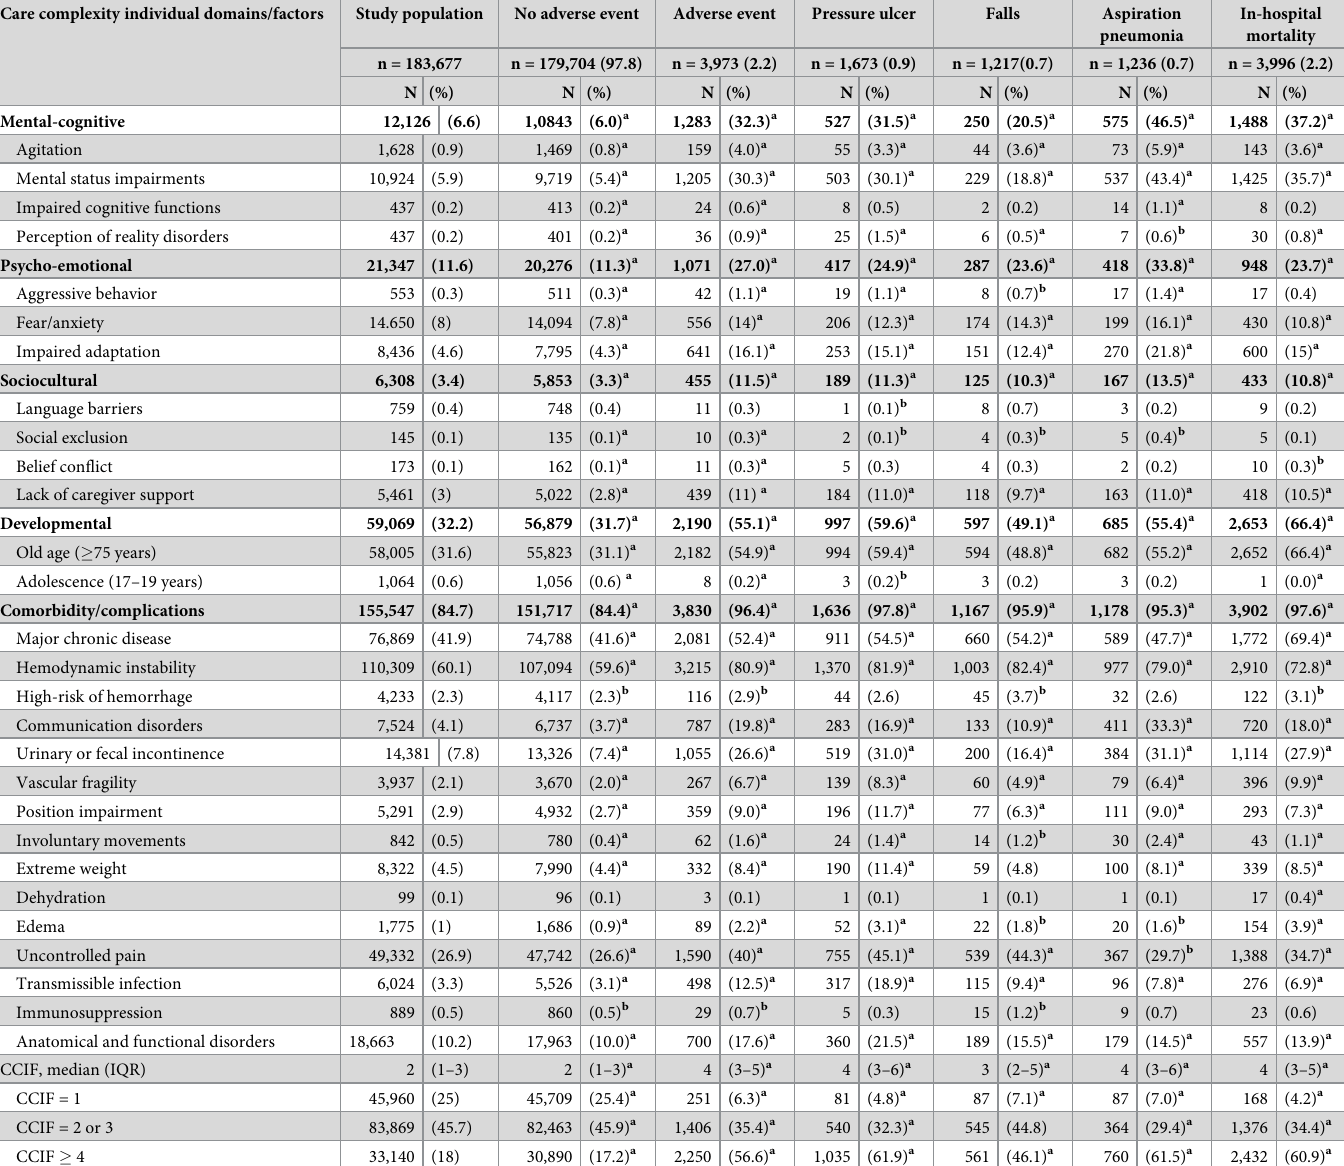
Table 2. Care complexity individual factors of adult hospitalized patients according to adverse events and in-hospital